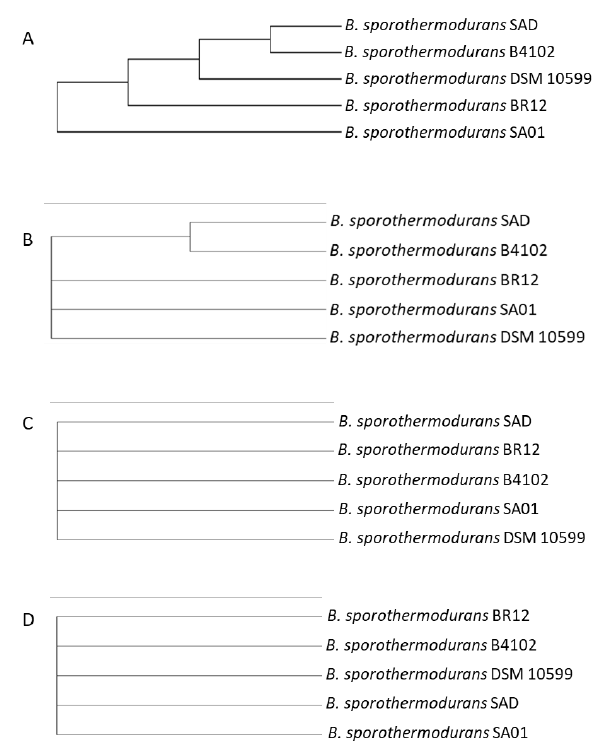
Figure 8. Molecular phylogenetic analysis by the maximum likelihood method of chaperon protein ClpB ( A ) and ATPases ClpC ( B ), ClpE ( C ), and ClpX ( D ). The evolutionary history was inferred by